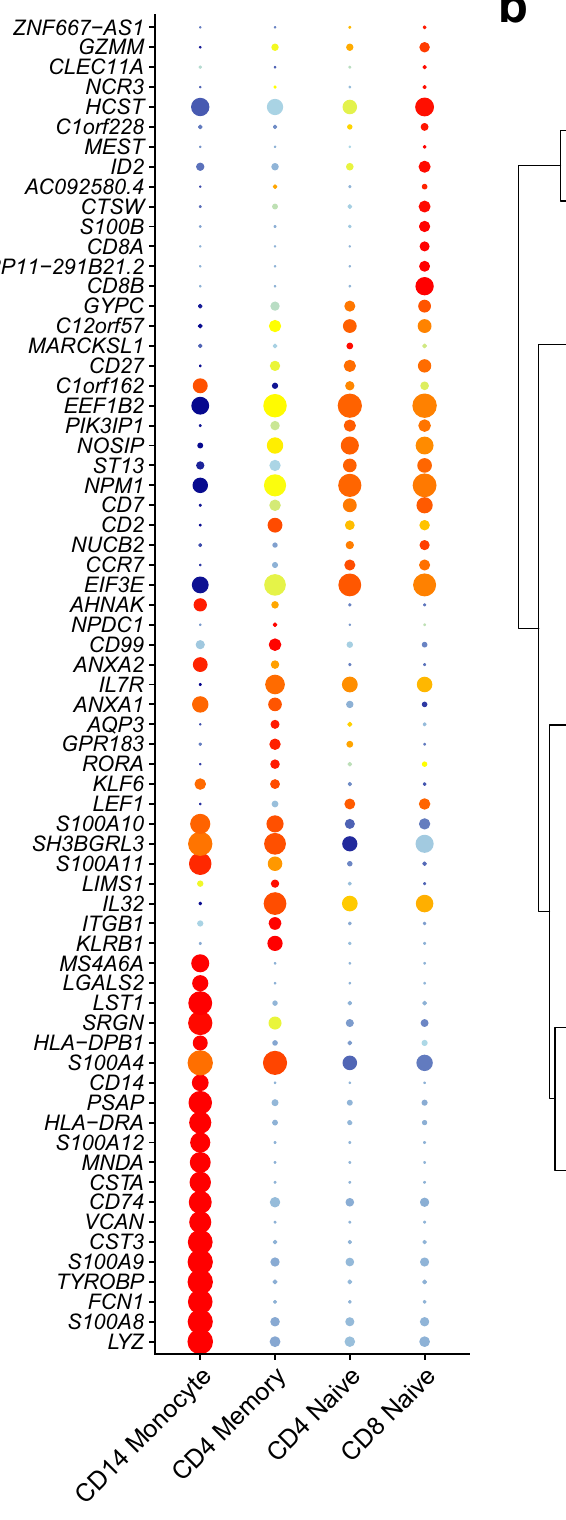
panel( a ),thedotsizeshowstheexpressionpercentageofageneinacelltype,and colorsshowtheaverageexpressionlevelofageneinacelltypewithblueaslowand red as